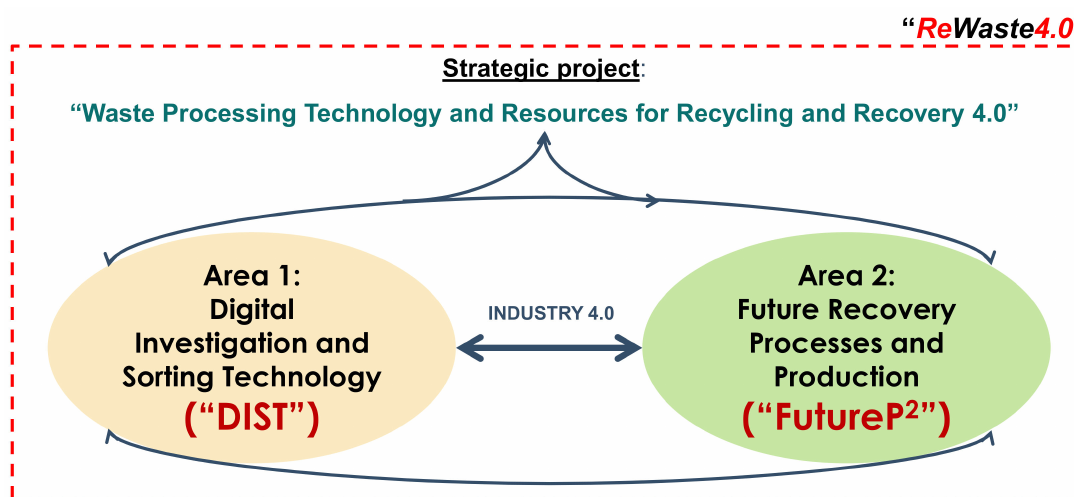
Figure 1. Holistic approach of ReWaste4.0—interdependencies of the strategic project and both areas connected by the approaches of Industry 4.0 [2].